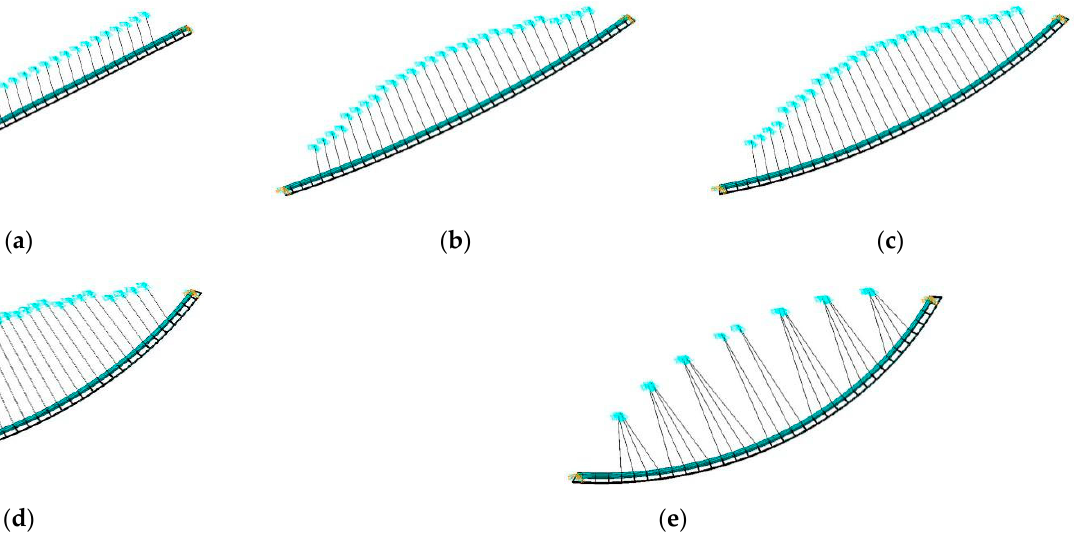
Figure 11. Diagram of curvature cases. ( a ) Curvature case 1 ( k = 0.0000), ( b ) Curvature case 2 ( k = 0.0024), ( c ) Curvature case 3 ( k = 0.0048), ( d ) Curvature case 4 ( k = 0.0072), ( e ) Curvature case 5 ( k = 0.0097).